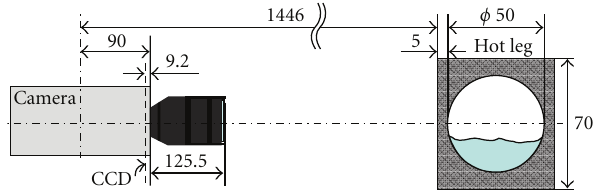
Figure 2: Cross-section of the hot leg pipe and position of the